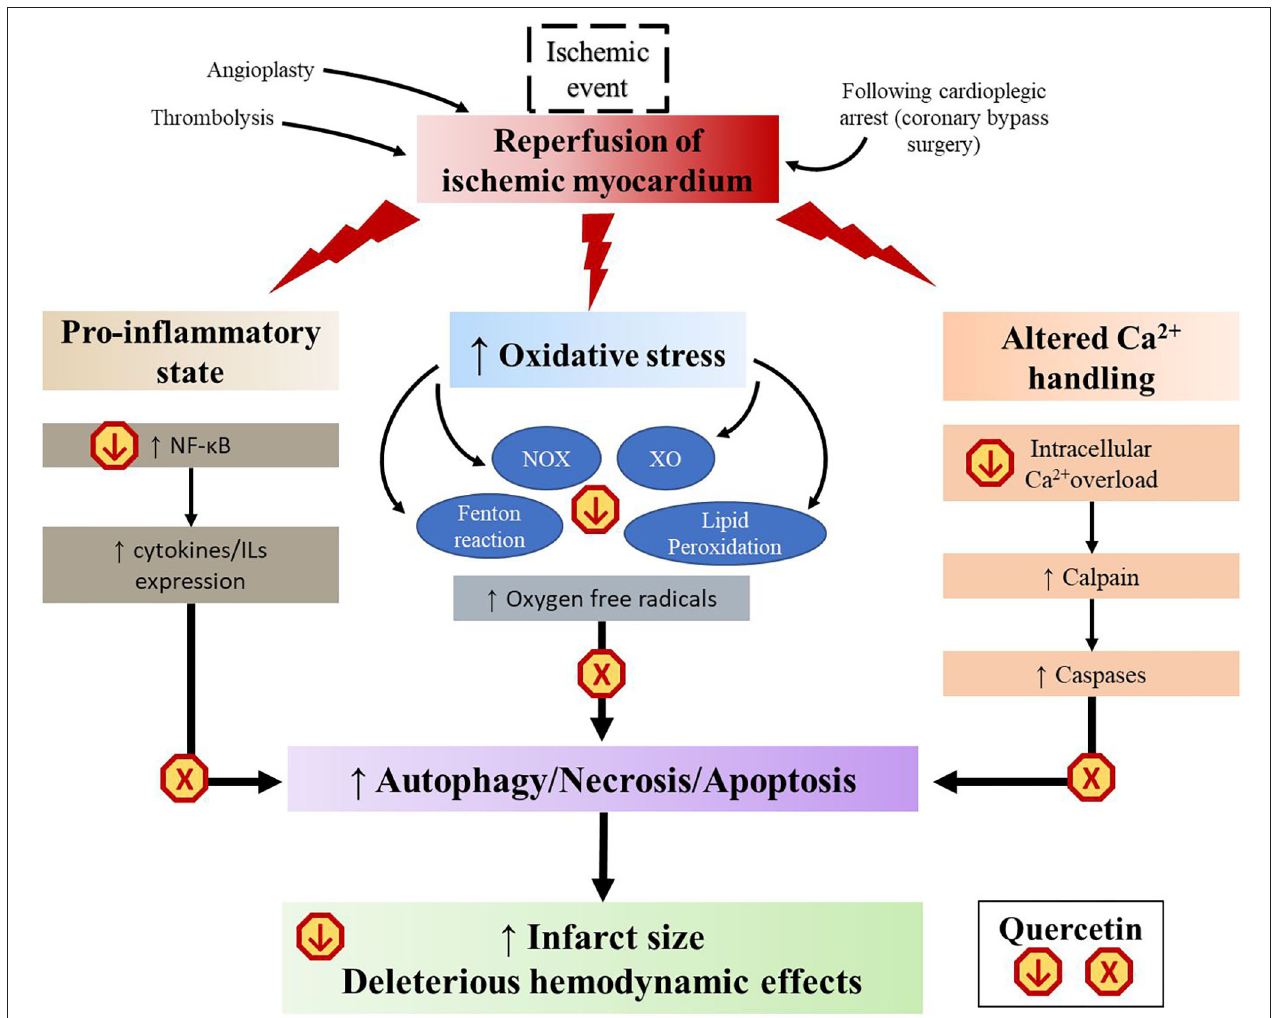
FIGURE 4 | Schematic representation of the multistep mechanisms of quercetin to mitigate myocardial ischemic reperfusion injury. XO, xanthine oxidase; NOX, NADPH oxidase.